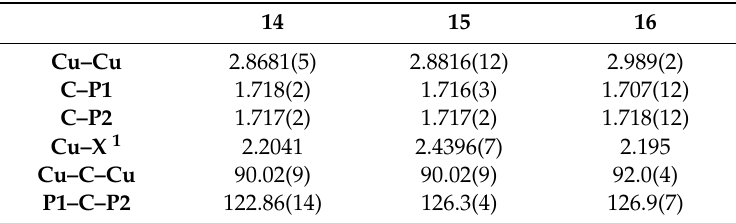
Table 2. Selected bond distances [Å] and angles [ ◦ ] for 14 – 16 .